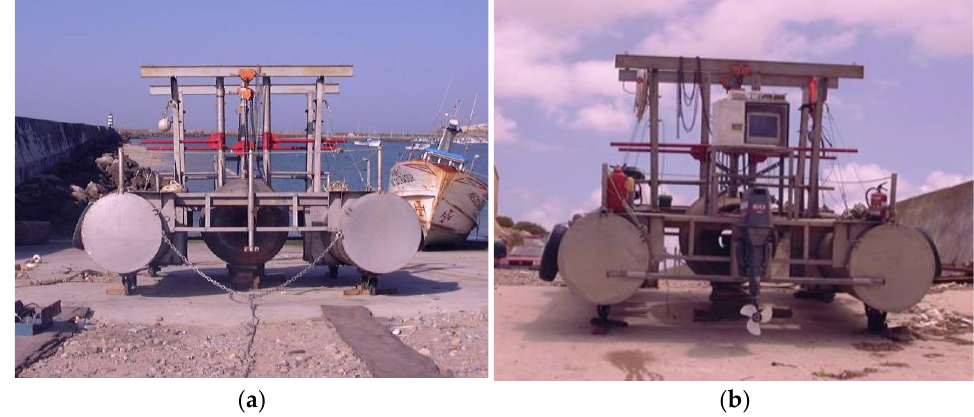
Figure 3. Front ( a ) and backward ( b ) views of the raft with the duct scale model D3 at a higher level at the naval dockyard ramp.